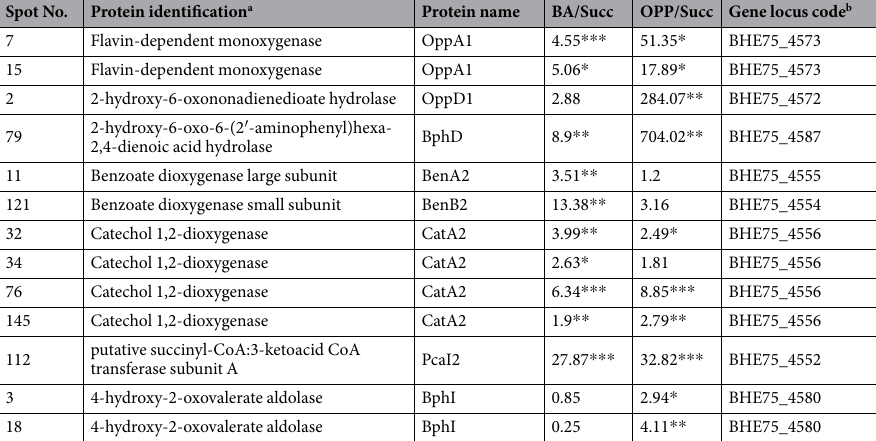
Table 2. Differentially expressed proteins with a putative role in the catabolism of ortho -phenylphenol (OPP) and benzoic acid (BA) in the proteome of S. haloaromaticamans grown on OPP or BA compared to cells grown on Succinate (Succ). The spot intensity ratios of the BA/Succ and OPP/Succ are shown as a measure of proteins differential expression. a Protein annotation based on homology with the translated genome of S. haloaromaticamans P3. b The locus number of the gene which showed the highest homology with the sequenced protein